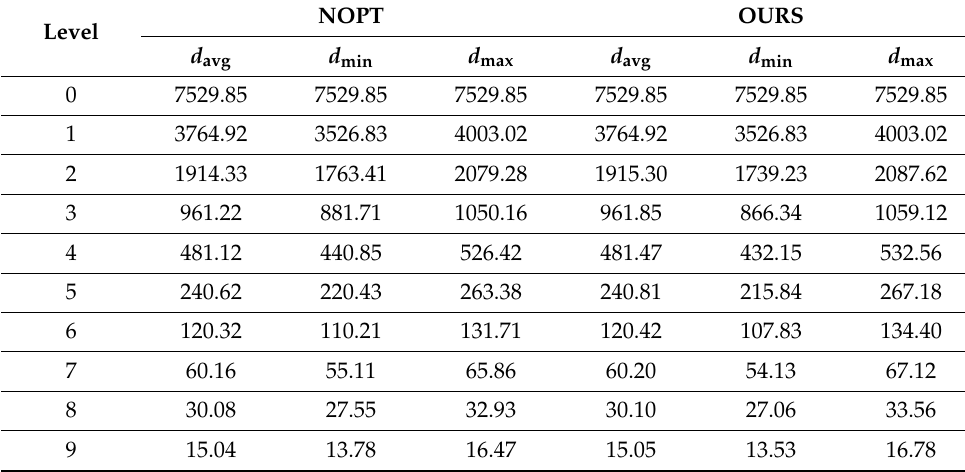
Table 6. d min , d max , d avg of different grids (unit: